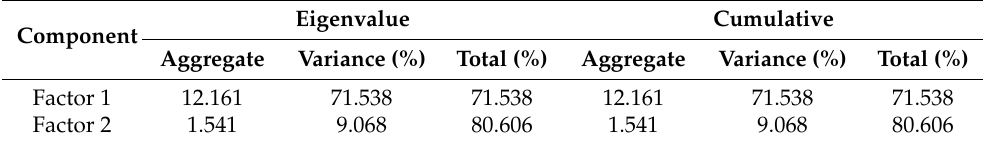
Table 11. Illustration of the total variance.